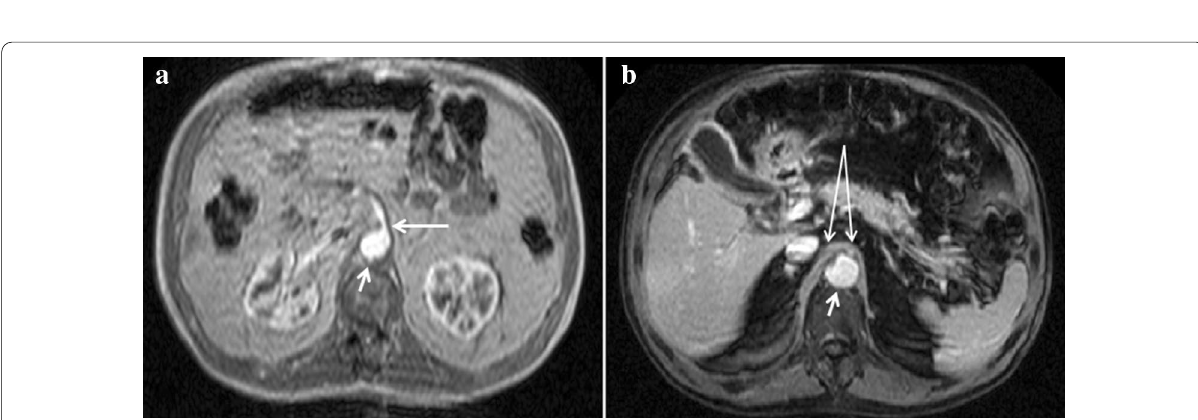
Fig. 18 Transverse sub-xiphoid Ultrasonographic scan. a Color Doppler US performed in inspiratory apnea that shows a regular diameter of the CA (short arrow). Epatic artery (long arrow). Splenic artery (head of arrow). b Color Doppler US performed in expiratory apnea that shows severe stenosis at the origin of the CA with aliasing due to turbulent flow and high-speed peak. c Duplex Doppler US of the CA performed in inspiratory apnea that shows a slight increase in peak speed. d Duplex Doppler of the CA performed in expiratory apnea that shows very high peak speeds (> 200 cm/s) due to severe